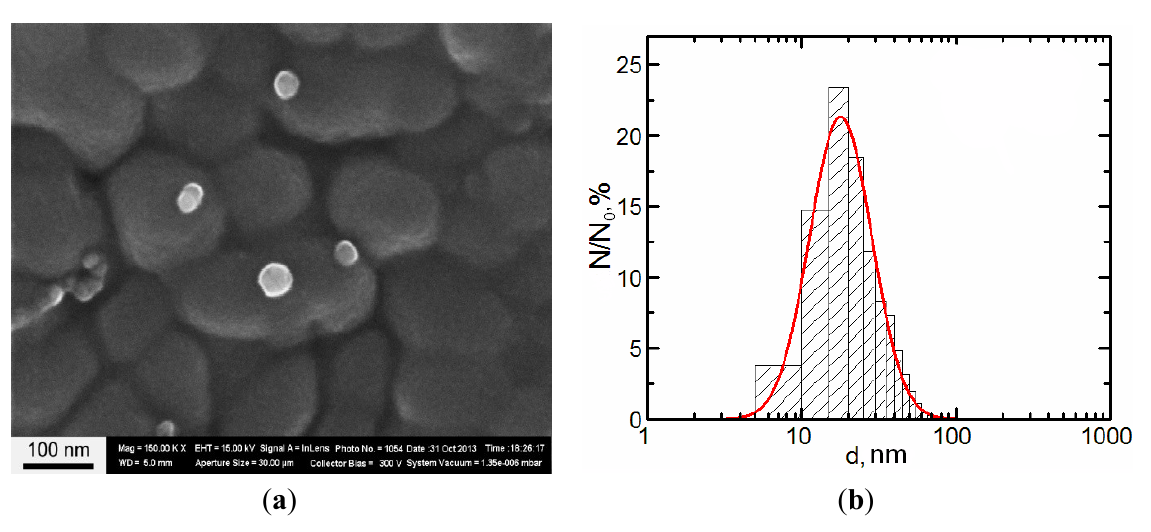
Figure 13. ( а ) Scanning electron microscopy (SEM) images of nanoparticles prepared for the experiment; and ( b ) particle size distribution function obtained by analysis of SEM images (N—number of particles of a given diameter, N